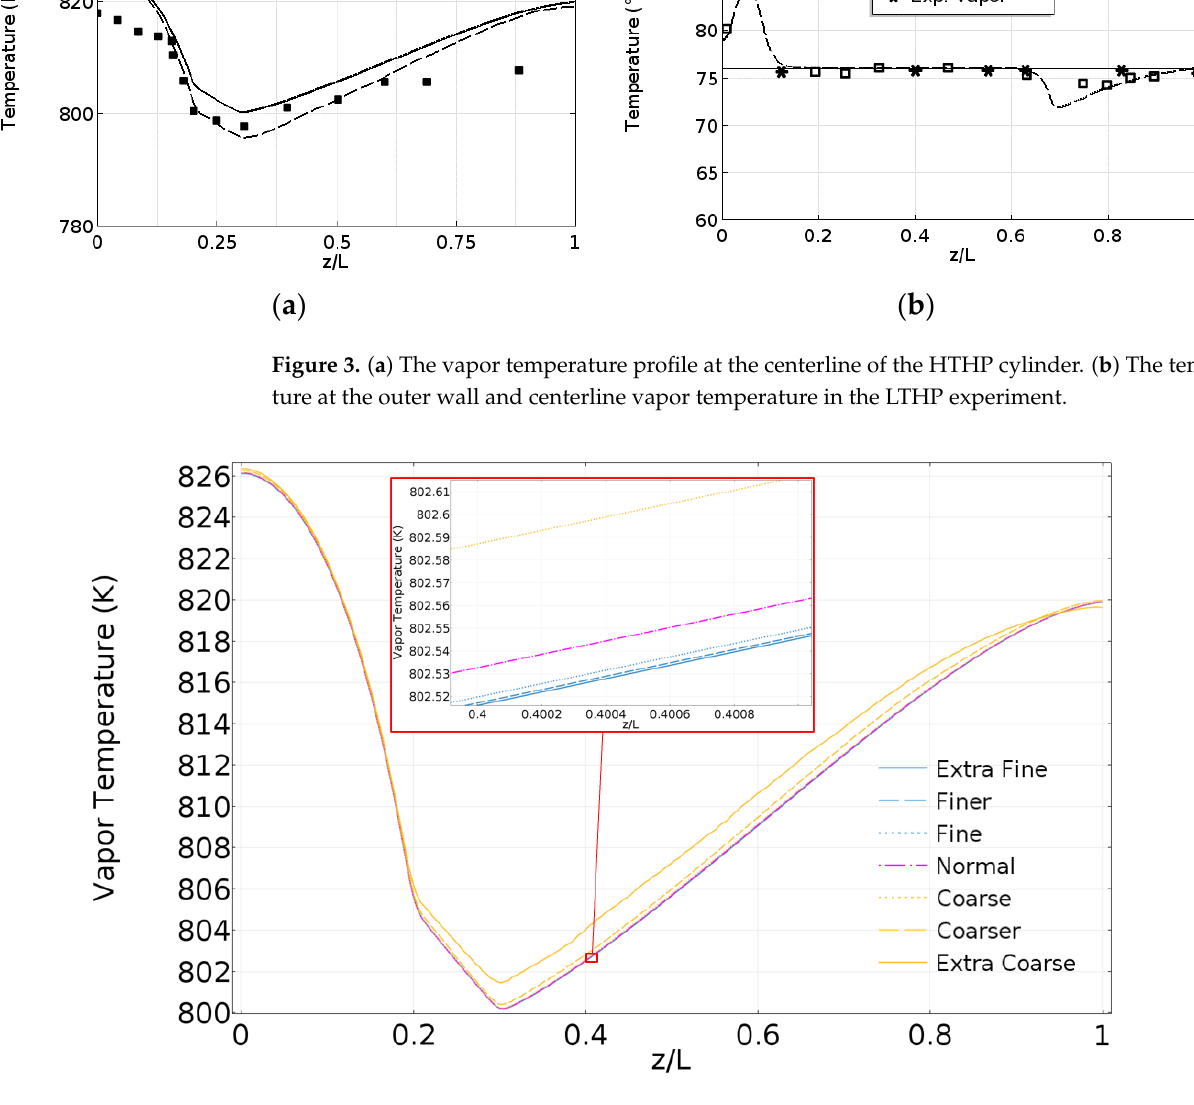
Figure 4. The steady-state solution for HTHP experiment at different mesh element size.